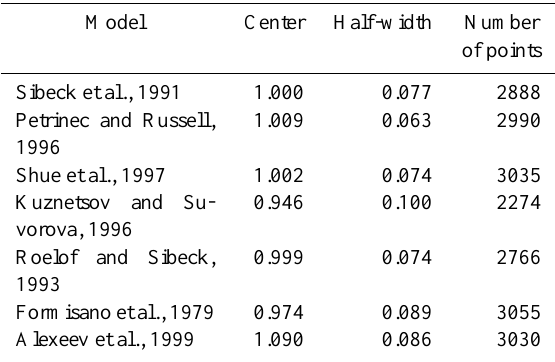
Table 3. Comparison of models in aberrated coordinates Model